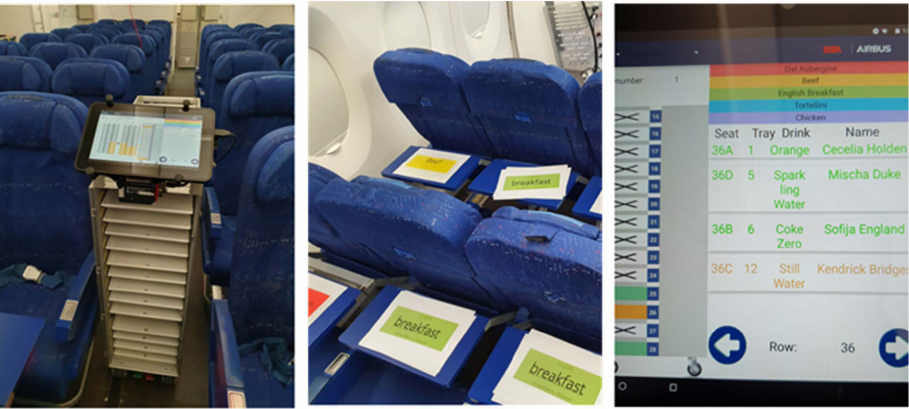
Figure 18. Validation set-up, from left to right: demonstrator, cardboard for passenger orders, and GUI demonstrator.